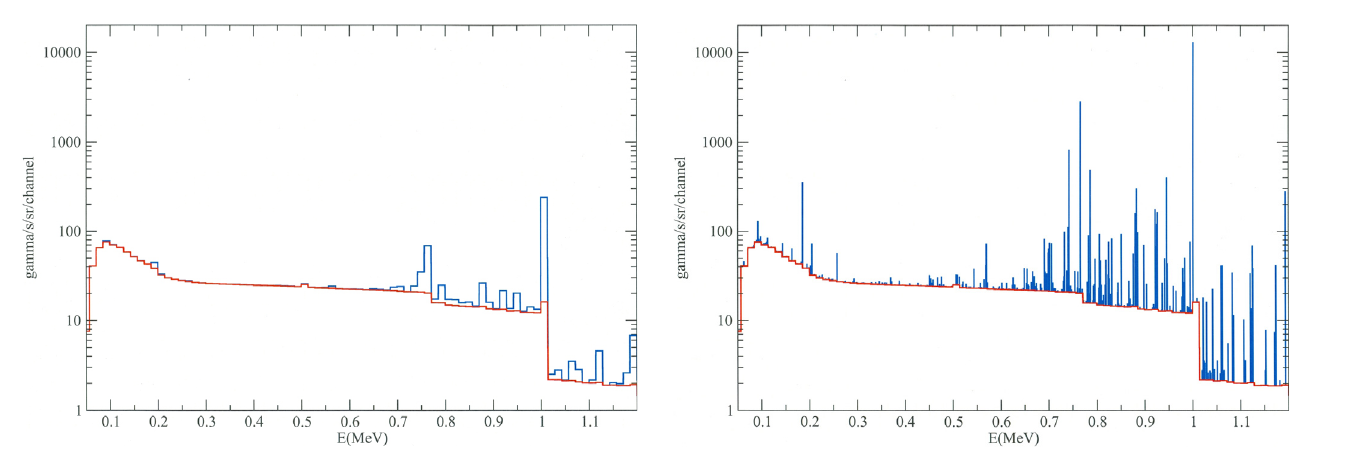
Fig. 3. Multigroup S N leakage spectra for both scattered background (red) and uncollided component (blue).